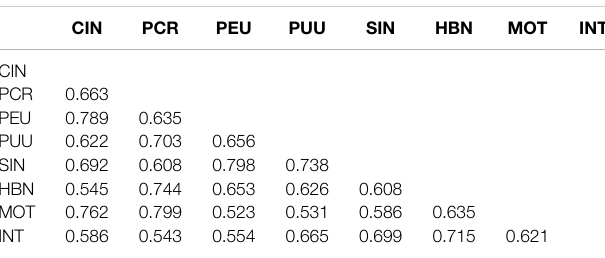
TABLE 6 | Results of HTMT ratio of correlations.